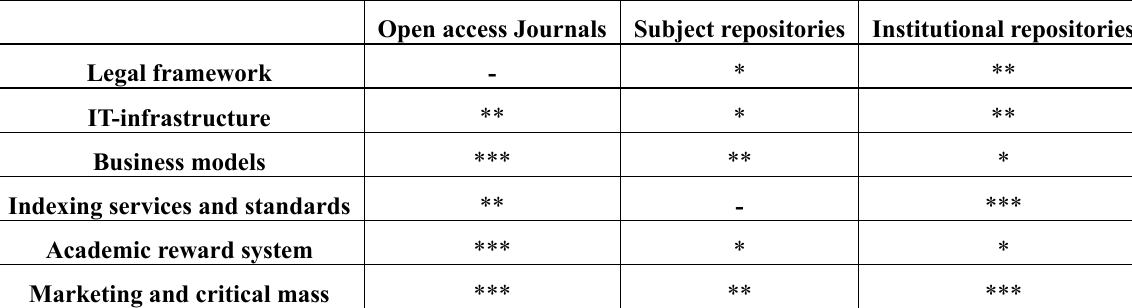
Table 1. A classification of different types of barriers for increased open access publishing and their relative importance, situation